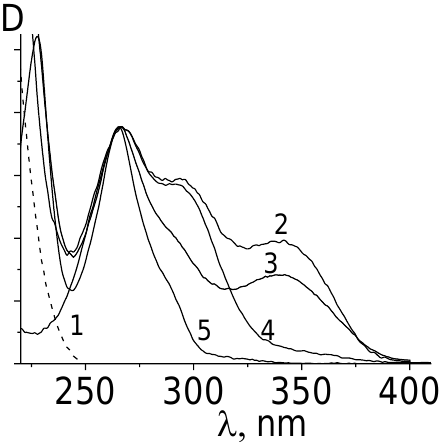
Figure 9. Normalized electronic absorption spectra of aqueous solutions: Eu 3+ /4-AM-VPA copoly- mer (Experiment 5, Table 1) ( 1 ), Eu 3+ /4-AM-VPA copolymer/TTA (2), Eu 3+ /4-AM-VPA copoly- mer/TTA/PHEN (3), TTA (4), and phenanthroline (5).